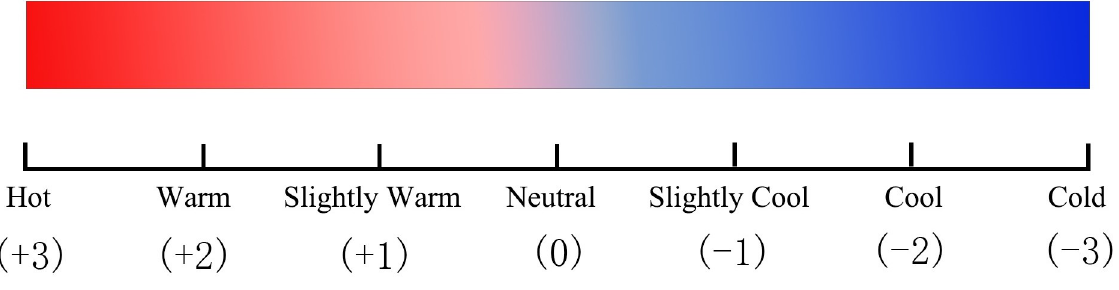
Fig 5. Thermal-sensation evaluation